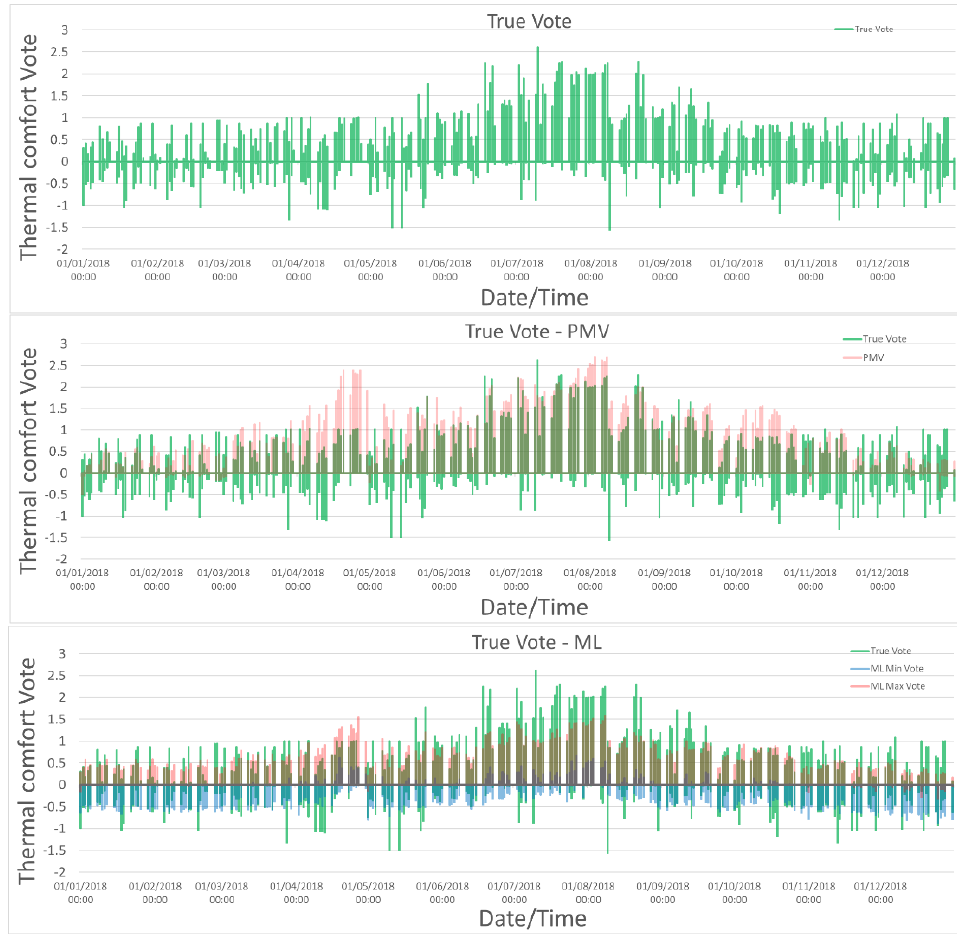
Figure 17. Comparison between the true comfort vote, the PMV evaluation, and the ML model re- sults.